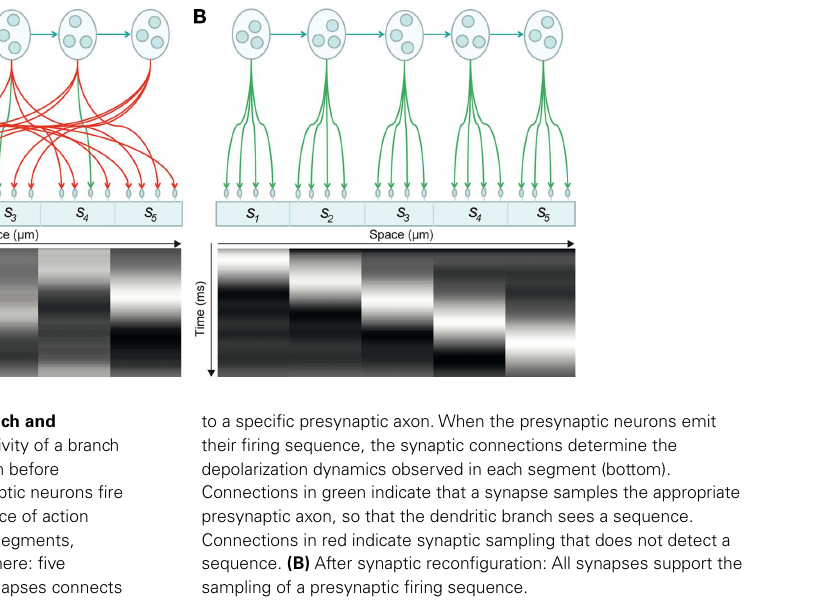
to a specific presynaptic axon.When the presynaptic neurons emit their firing sequence, the synaptic connections determine the depolarization dynamics observed in each segment (bottom). Connections in green indicate that a synapse samples the appropriate presynaptic axon, so that the dendritic branch sees a sequence. Connections in red indicate synaptic sampling that does not detect a sequence. (B) After synaptic reconfiguration: All synapses support the sampling of a presynaptic firing